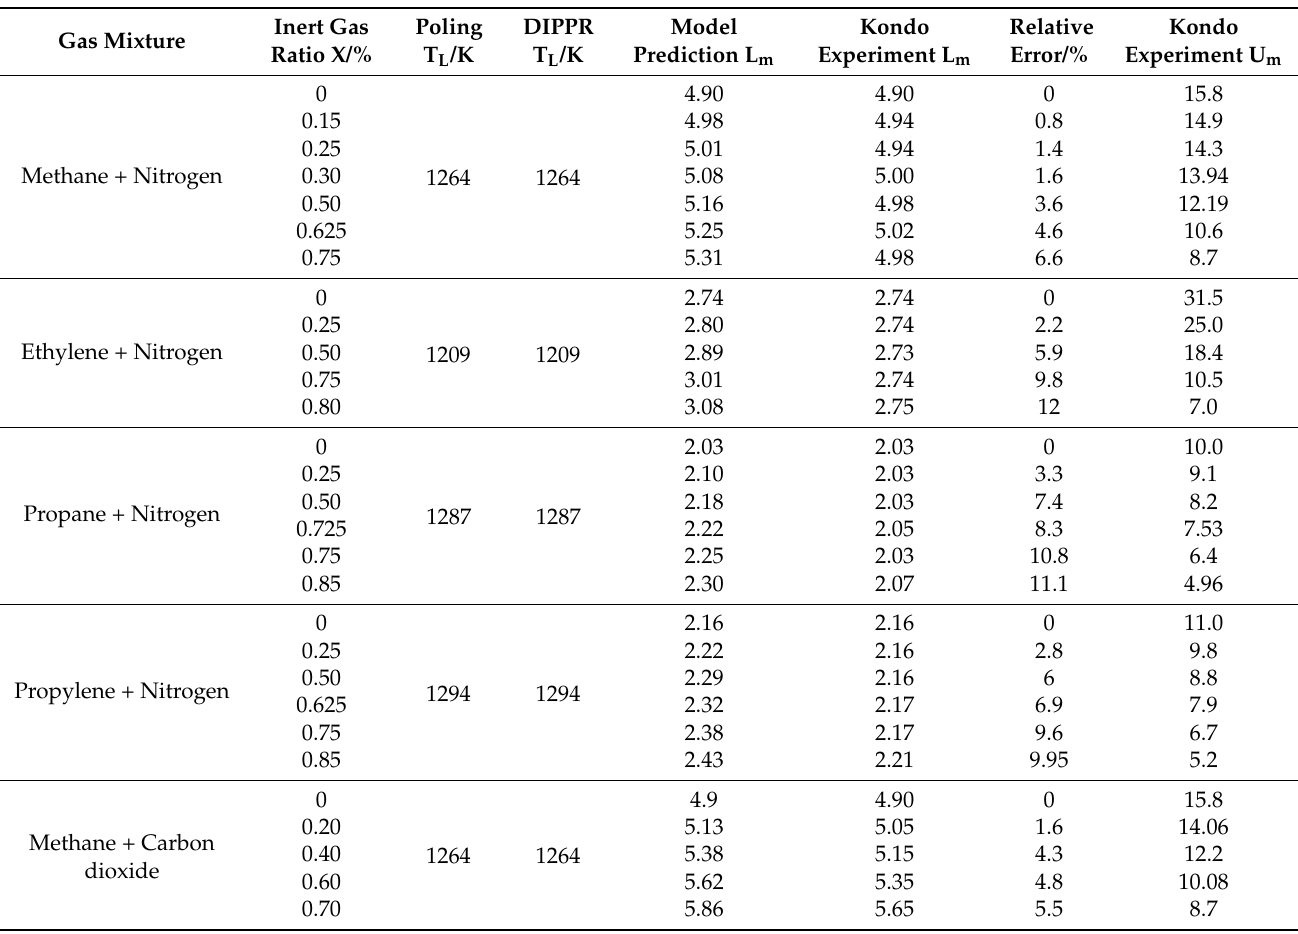
Table 2. Theoretical predicted values and experimental values of lower explosion